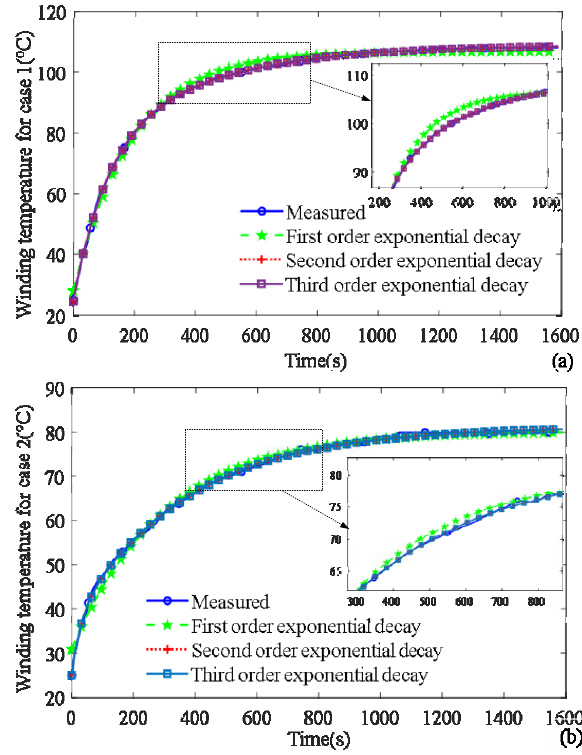
Figure 10. Measured winding temperature. ( a ) 3000 rpm −− 40 kW, ( b ) 6000 rpm −− 40 kW.